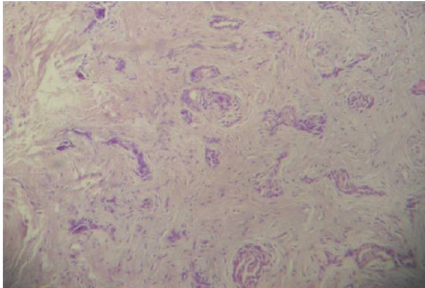
Figure 2: Histopathological picture showing odontogenic epithelial islands in mature fibrous stroma (4x magnification, H&E staining).